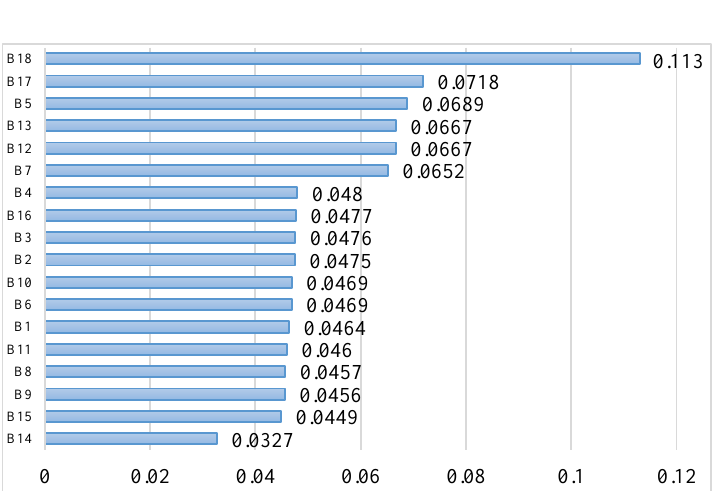
Fig. 2. Weights of executive